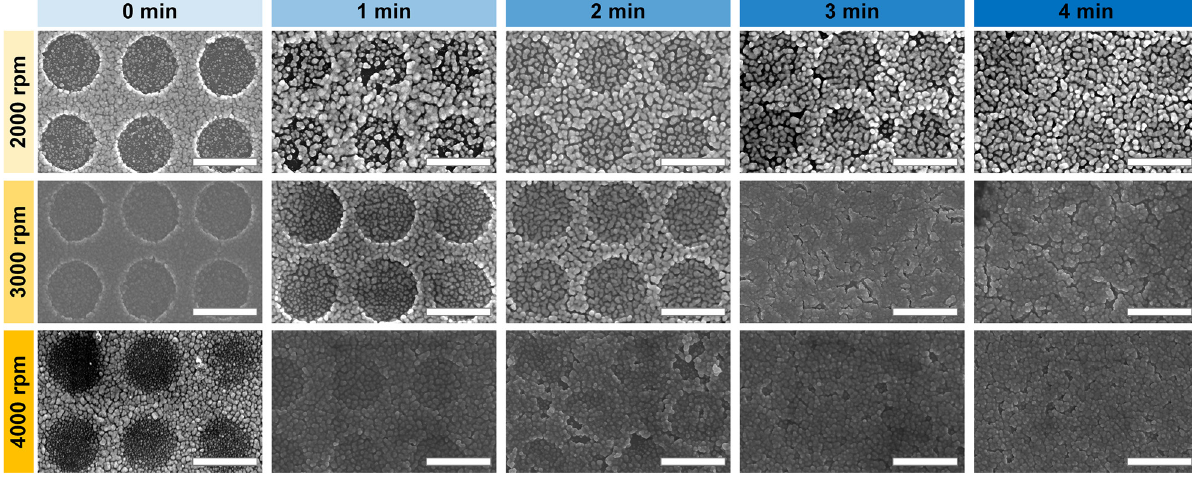
Figure 3: SEM images of Ag nanohole patterns fabricated by performingsoft NIL onto the 50 vol% ionic Ag ink-coated substrates.The coating speeds and soft baking times for preparing the ionic Ag ink coatings were varied: 2000, 3000, and 4000 rpm, and 0, 1, 2, 3, and 4 min, respectively. All scale bars: 1